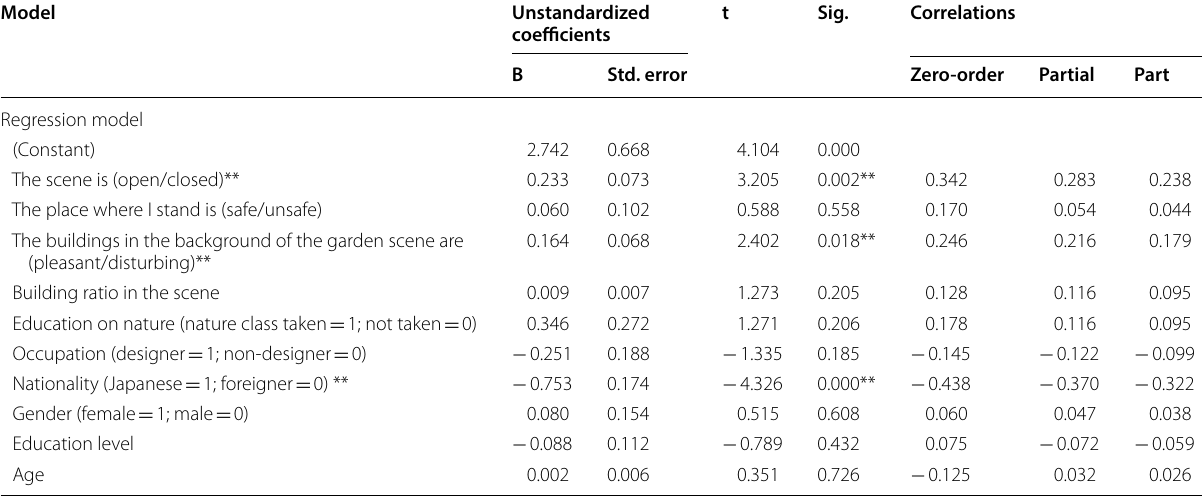
Table 5 Multiple linear regression analysis for the relationships between the variables and general landscape